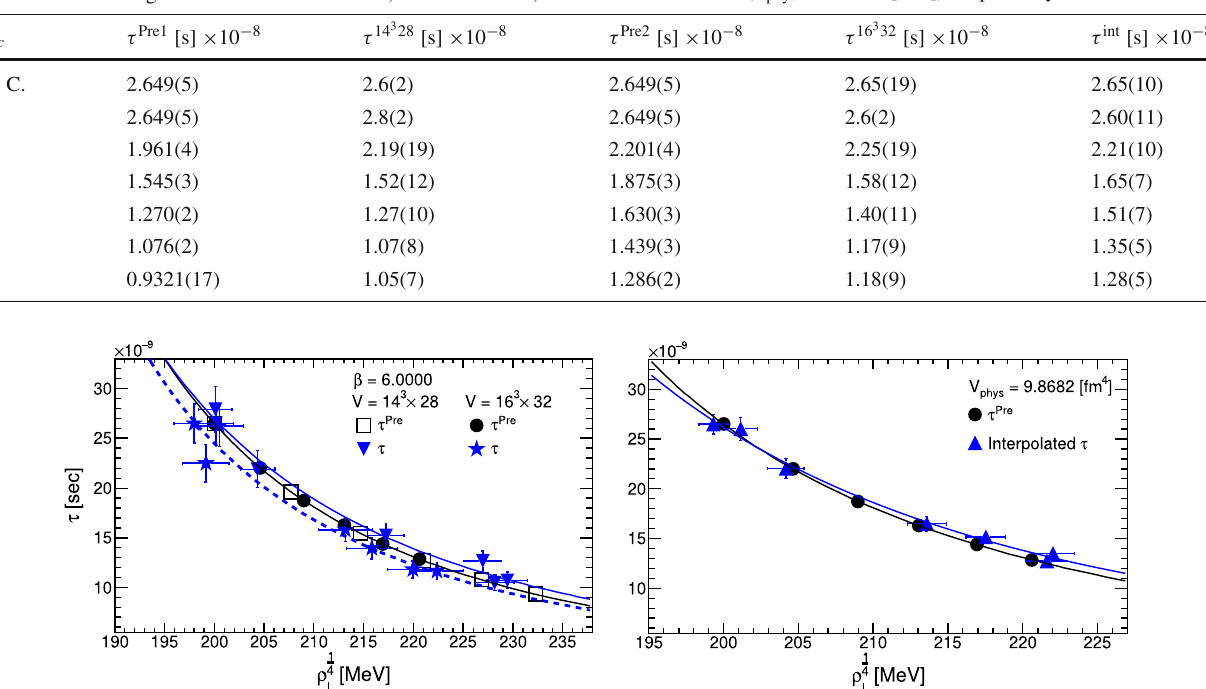
the interpolated results, respectively. The predictions τ Pre1 and τ Pre2 are for the lattice volumes V = 14 3 × 28 ( V phys = 5 . 7845 [fm 4 ]) and